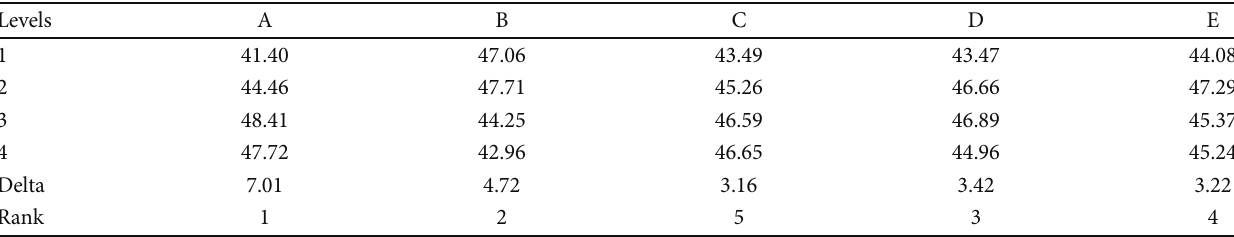
Table 3: S/N values of adsorption for storage system.